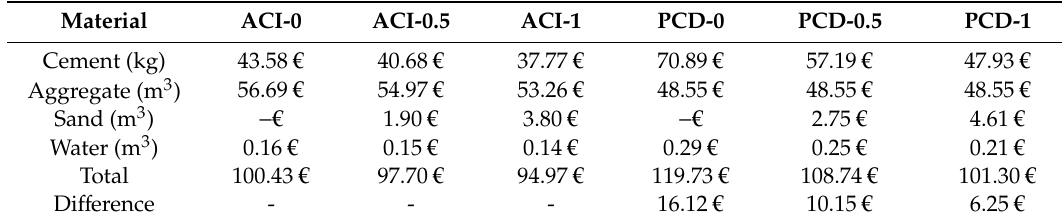
Table 7. Economic analysis between the PCD and ACI 522R-10